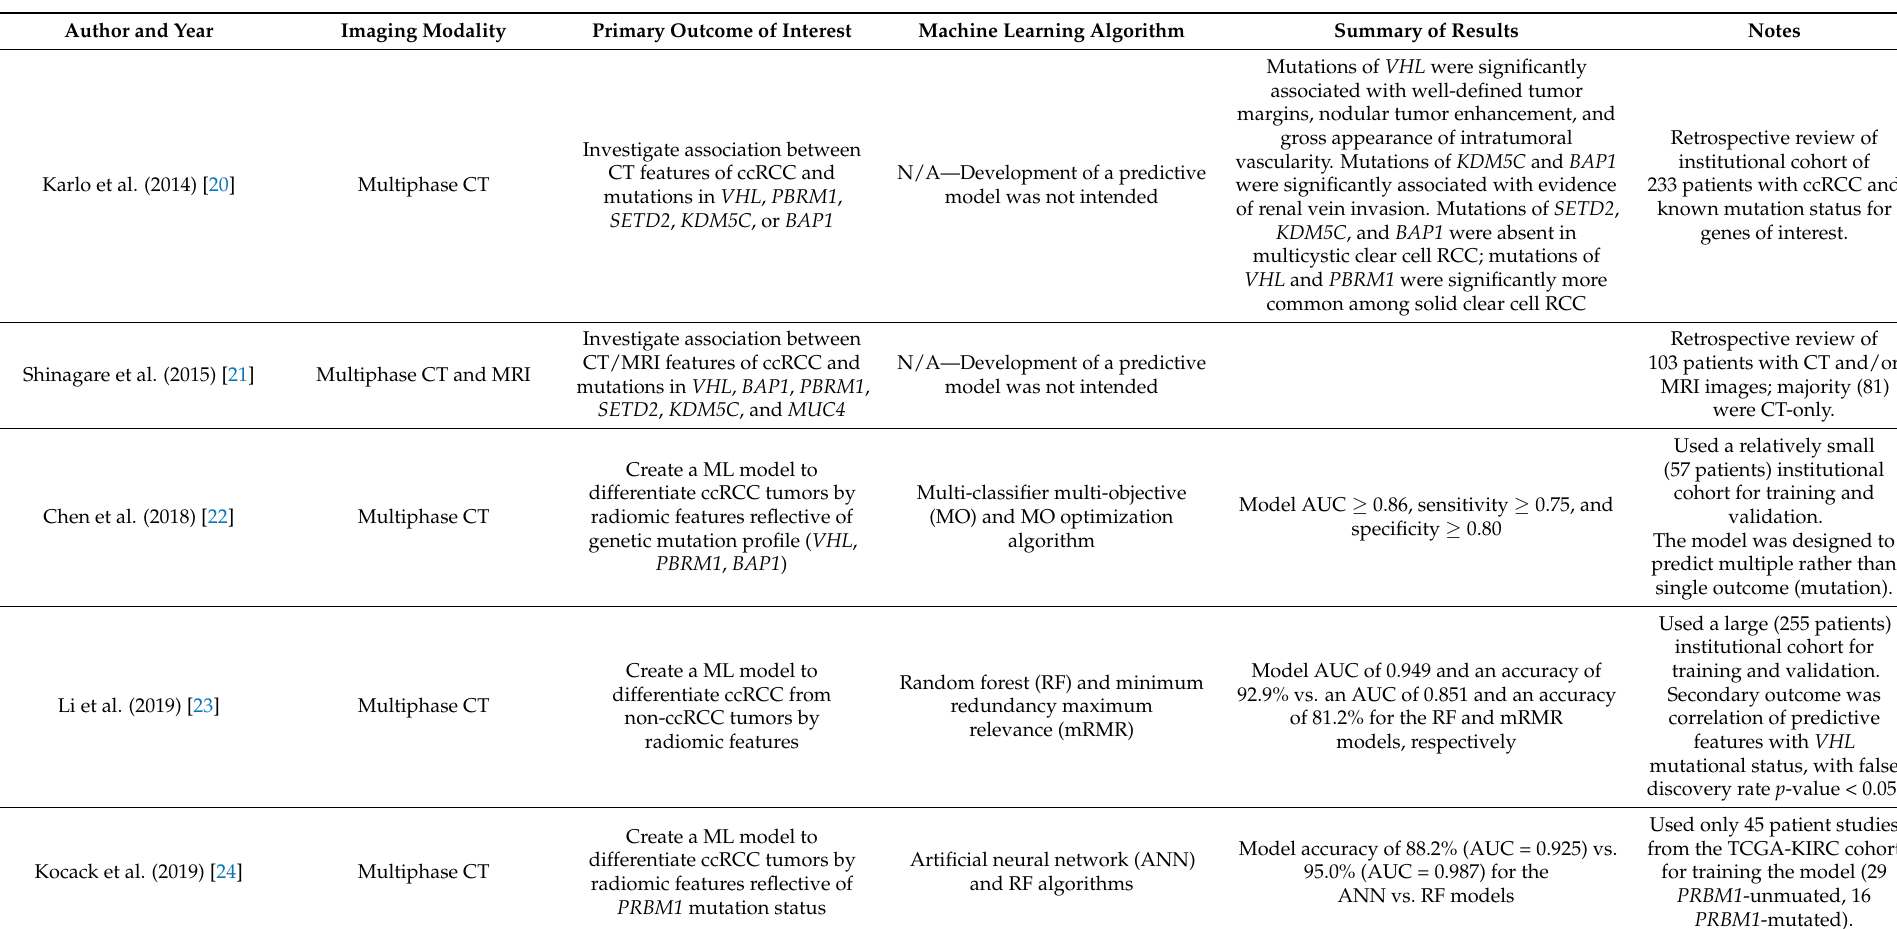
Table 1. Summary of included radiogenomic studies in this review. Studies were selected based on the literature search strategy summarized in the methods section and Figure 1. Most studies utilized studies from the publicly available TCGA-KIRC cohort, specifically focusing on patients in that database with corresponding imaging studies in the TCIA